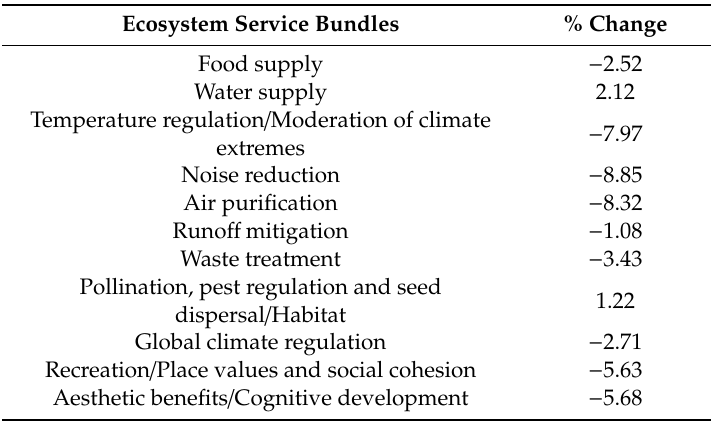
Table 5. Ecosystem service bundle changes and the percentage of change.